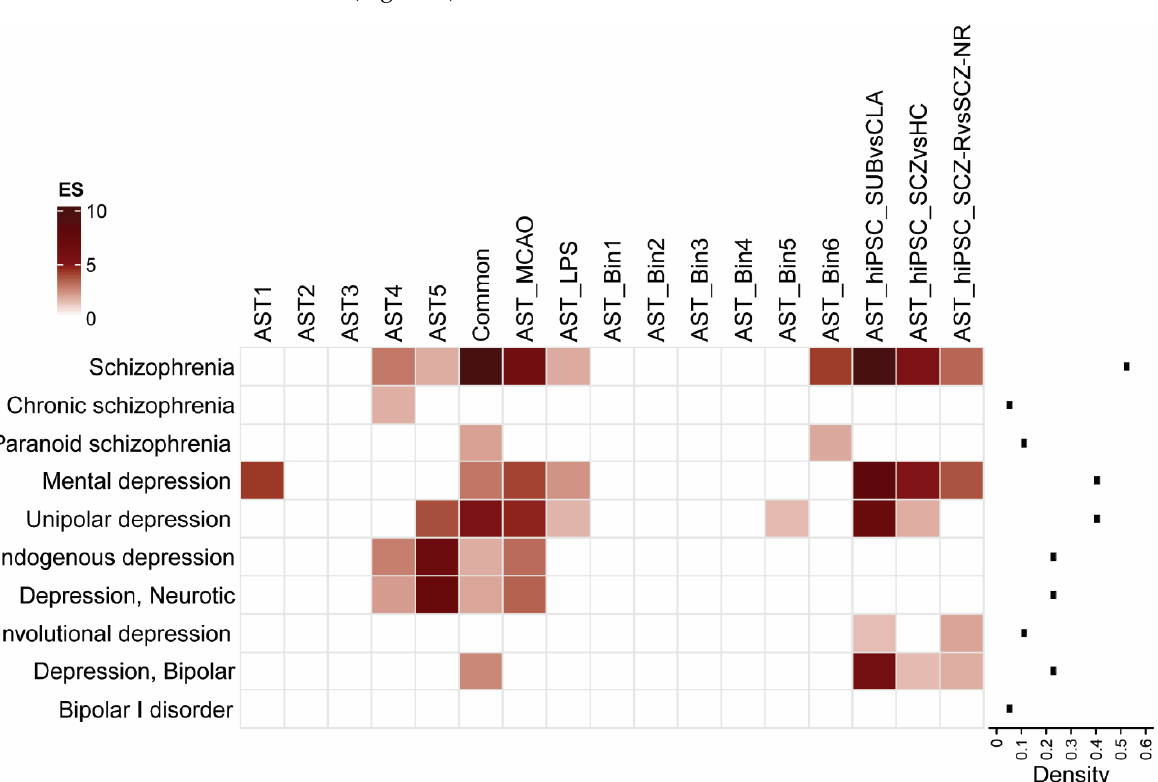
Figure 1. Gene enrichment of mouse astrocyte subtype gene-sets (AST1-5, common), mouse disease model astrocyte gene-sets (AST_MCAO, AST_LPS), and proxy human astrocyte gene-sets (AST_Bin1-6) across neuropsychiatric and neurological disorders (y-axis). Color intensity is propor- tional to -log10( p -value). Density index for all astrocyte gene-sets across all disorders is displayed to right of heatmap. AST astrocyte, CLA astrocyte classical subtype, ES enrichment score, HC healthy control, hiPSC human induced pluripotent stem cell, LPS lipopolysaccharide, MCAO middle cerebral arterial occlusion. SCZ schizophrenia, SCZ_R clozapine responder, SCZ_NR clozapine non-responder, SUB astrocyte